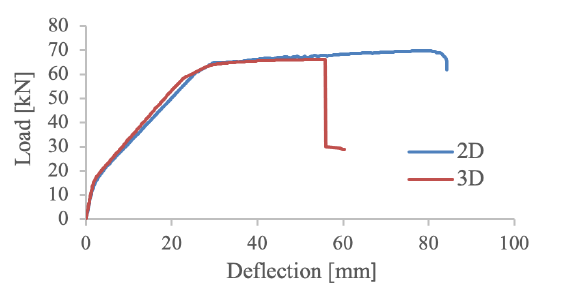
Figure 3. A comparison between the 2D and 3D loading curve - a reference panel with default material